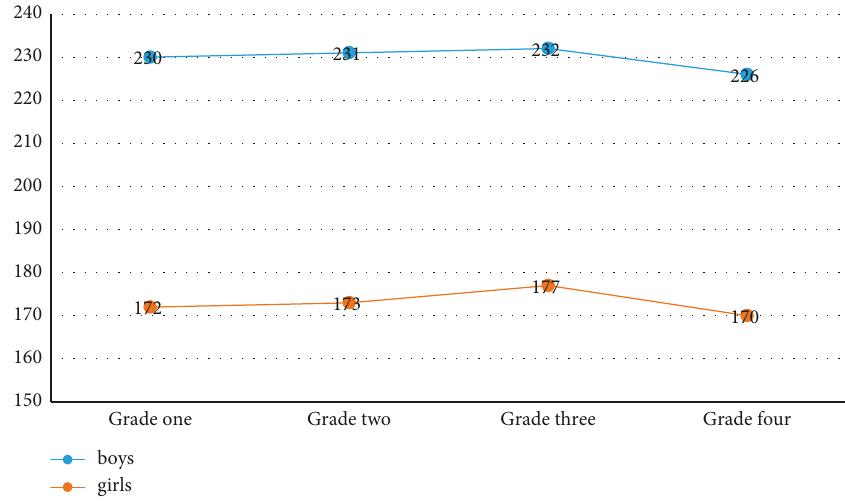
Figure 2: The result change curve of standing long jump between boys and girls. Table 6: Girls’ trunk forward bending scores and grade ratio.